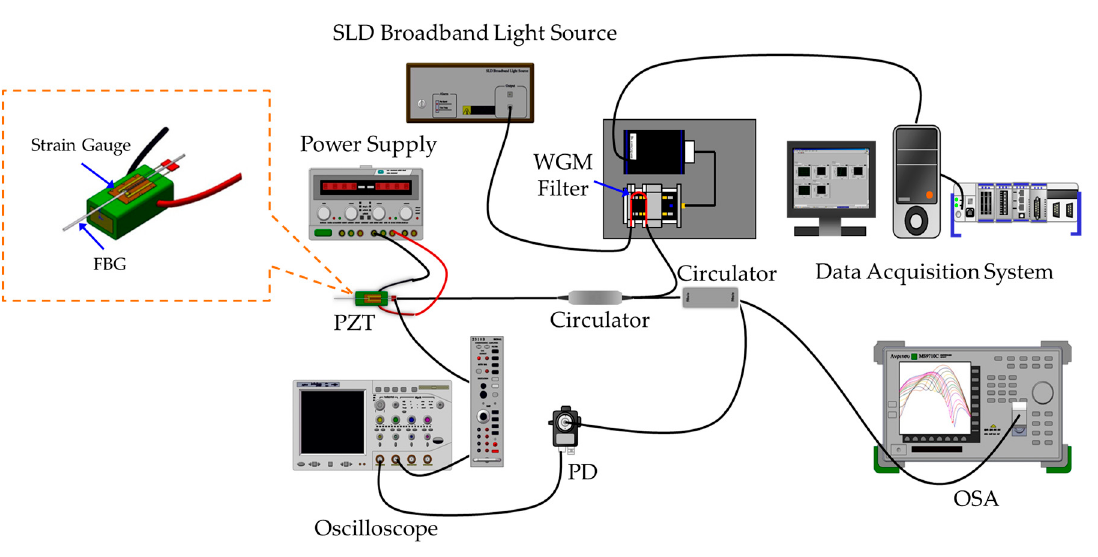
Table 1. The signal ‐ to ‐ noise ratio (SNR) of the fiber Bragg grating (FBG) interrogation system based on whispering gallery mode (WGM) edge filter. PZT: piezoelectric transducer.